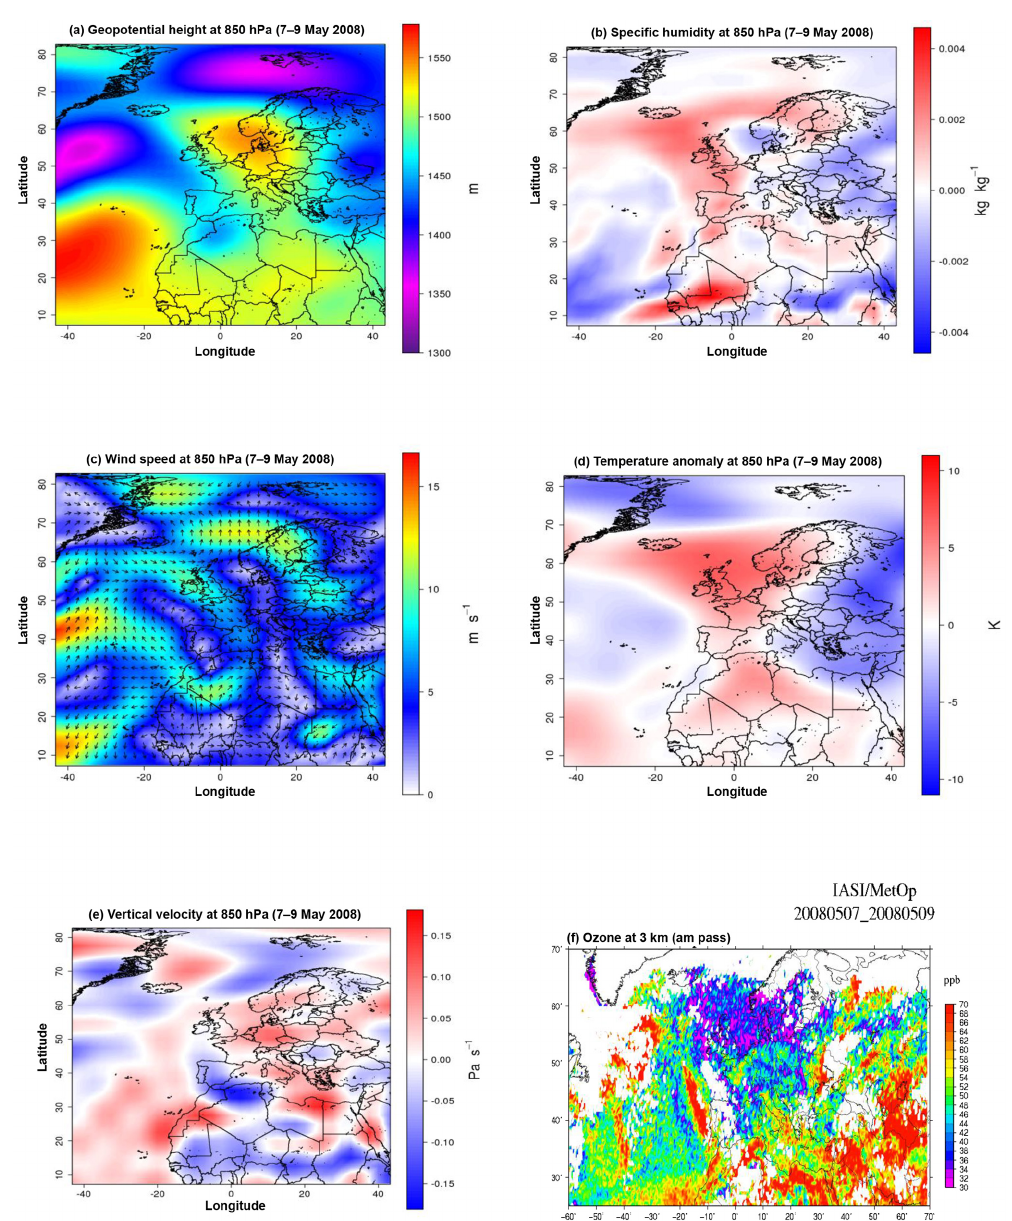
Figure 7. Composite NOAA/ESRL weather maps of geopotential height ( a ; in m), specific humidity anomaly ( b ; in KgKg − 1 ), vector wind ( c ; in ms − 1 ), air temperature anomaly ( d ; in K), omega vertical velocity ( e ; in Pas − 1 ) and IASI satellite ozone measurements at 3km ( f ; in ppb) for the high ozone episode of 7–9 May